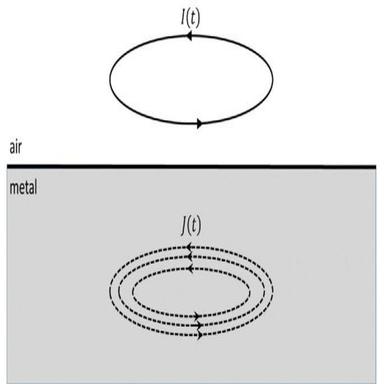
Electromagnetic induction of eddy current in an electrically condictive material.